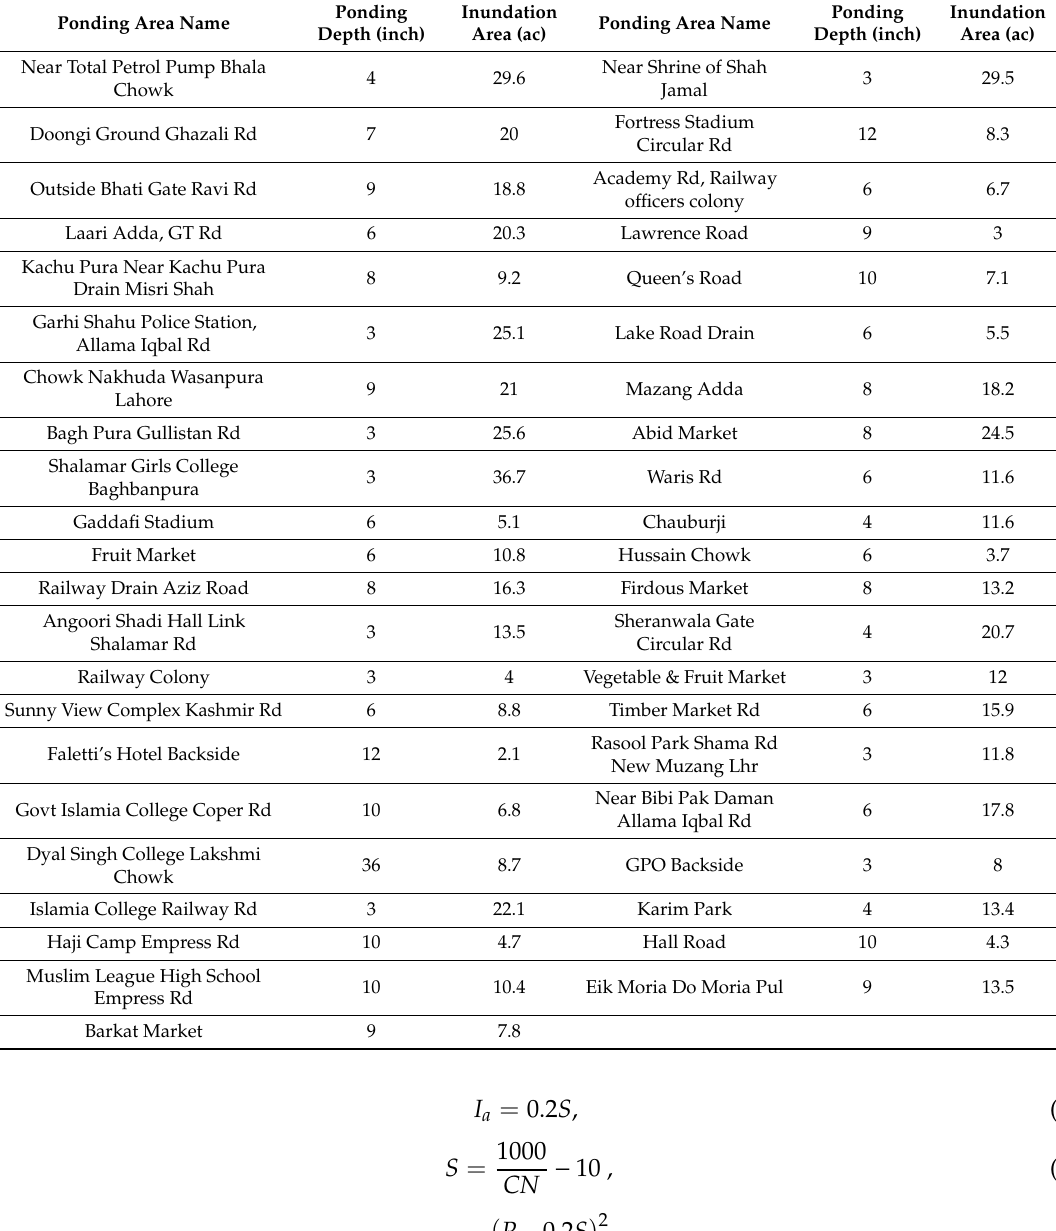
Table 1. Critical ponding roads with ponding depth and inundation